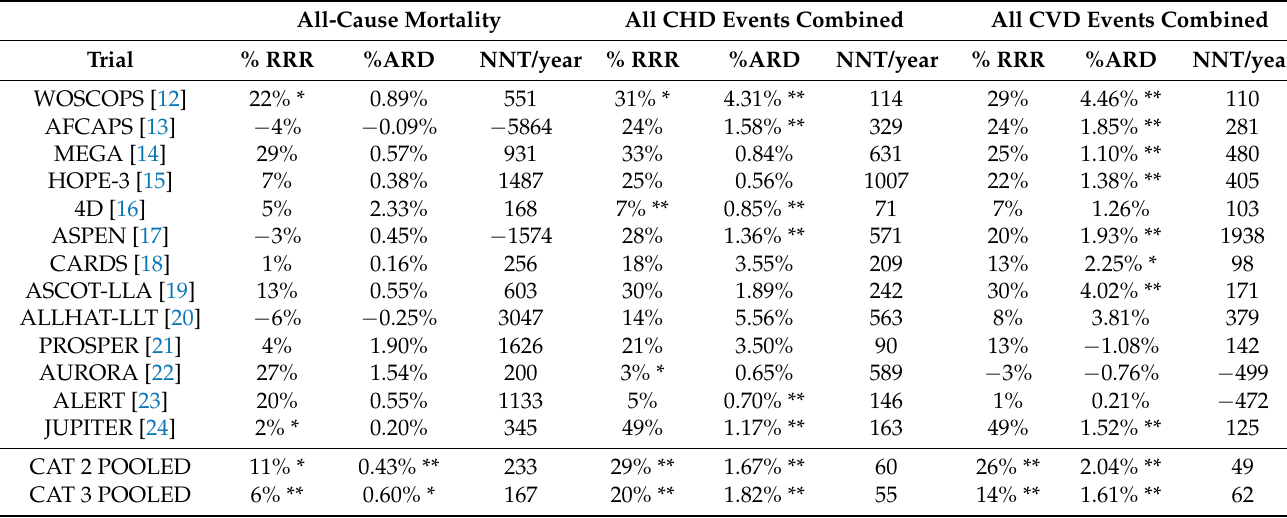
Table 7. Relative Risk Reduction (RRD), Absolute Risk Difference (ARD) and Number Needed to Treat (NNT)/year in the trials for all of the present study’s outcomes. * Significant to p ≤ 0.05; ** significant to p ≥ 0.01.